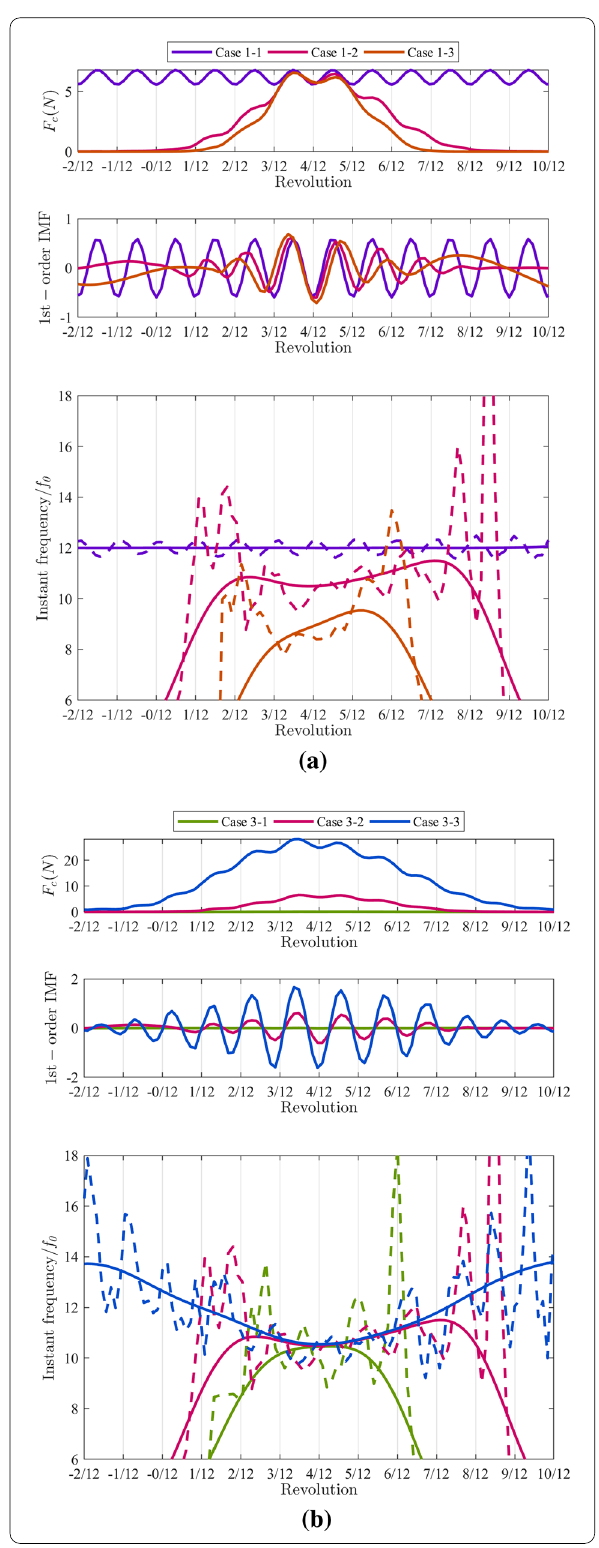
Figure 9 Time-frequency analysis. Smooth was applied on the directly generated transient frequency (by the dashed lines) to obtain the solid lines: ( a ) The first 3 cases in Group 1, ( b ) The Group 3